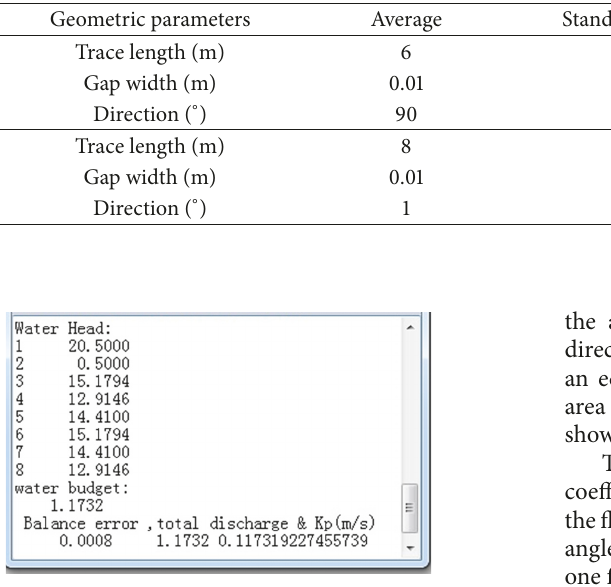
Figure 3: Calculation results of the FractureToKarst.